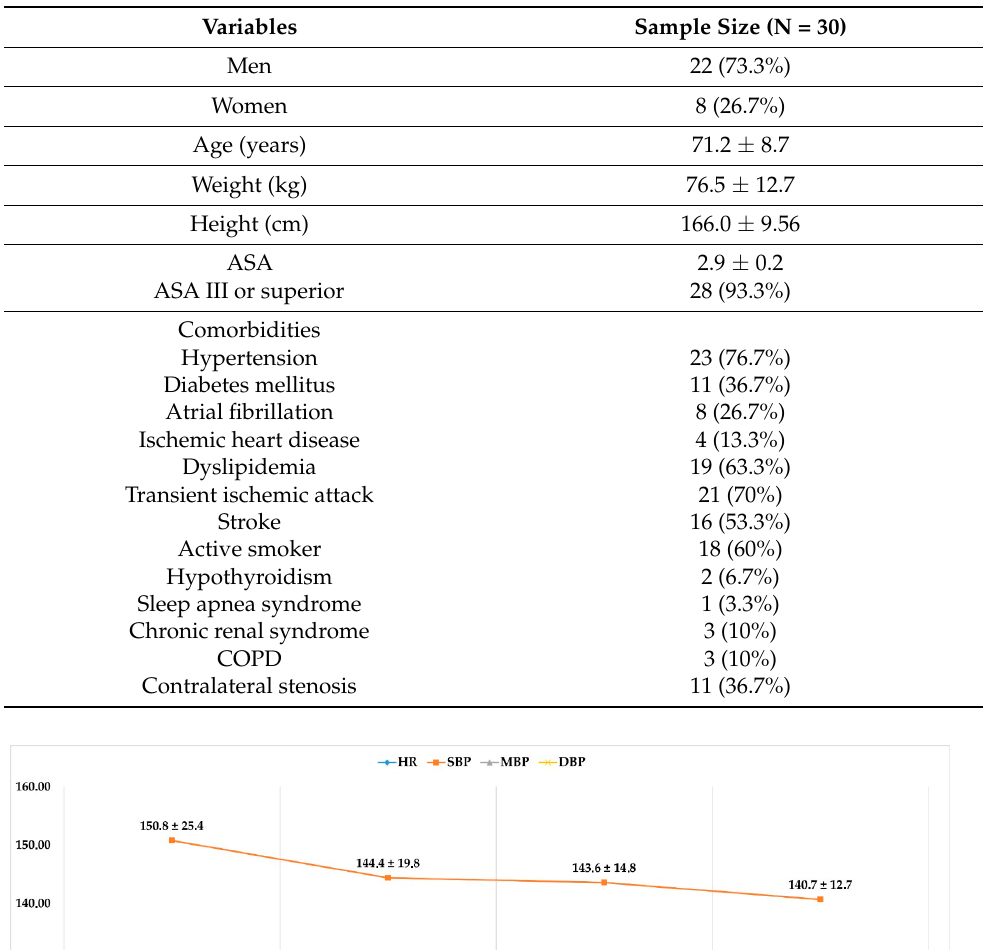
Table 1. Demographic data and comorbidities. Data are expressed as percentages and as mean +/ − SD. ASA, American Society of Anesthesiology; COPD, chronic obstructive pulmonary disease.